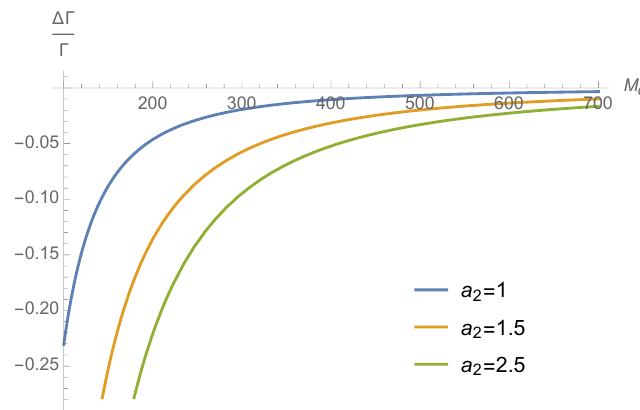
Figure 2 . Relative change in the Higgs di-photon decay rate induced by a scalar electroweak multiplet and the interaction in eq. (2.7b). A (cid:12)rst order EWPT to the Higgs vacuum in